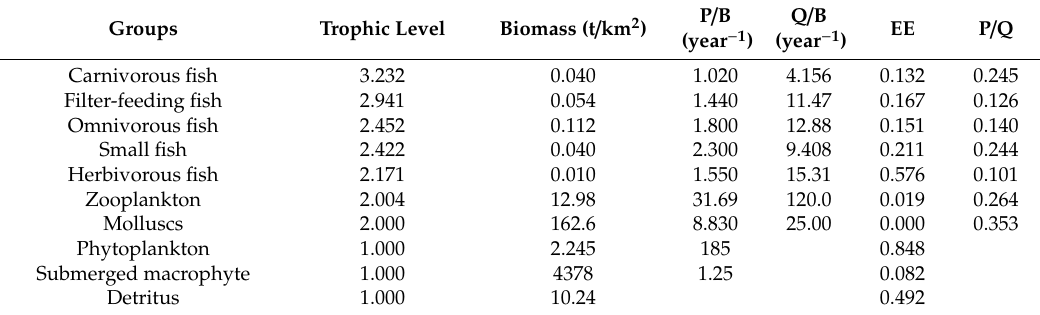
Table 2. Input and output (BOLD) parameters of the Lake Datong